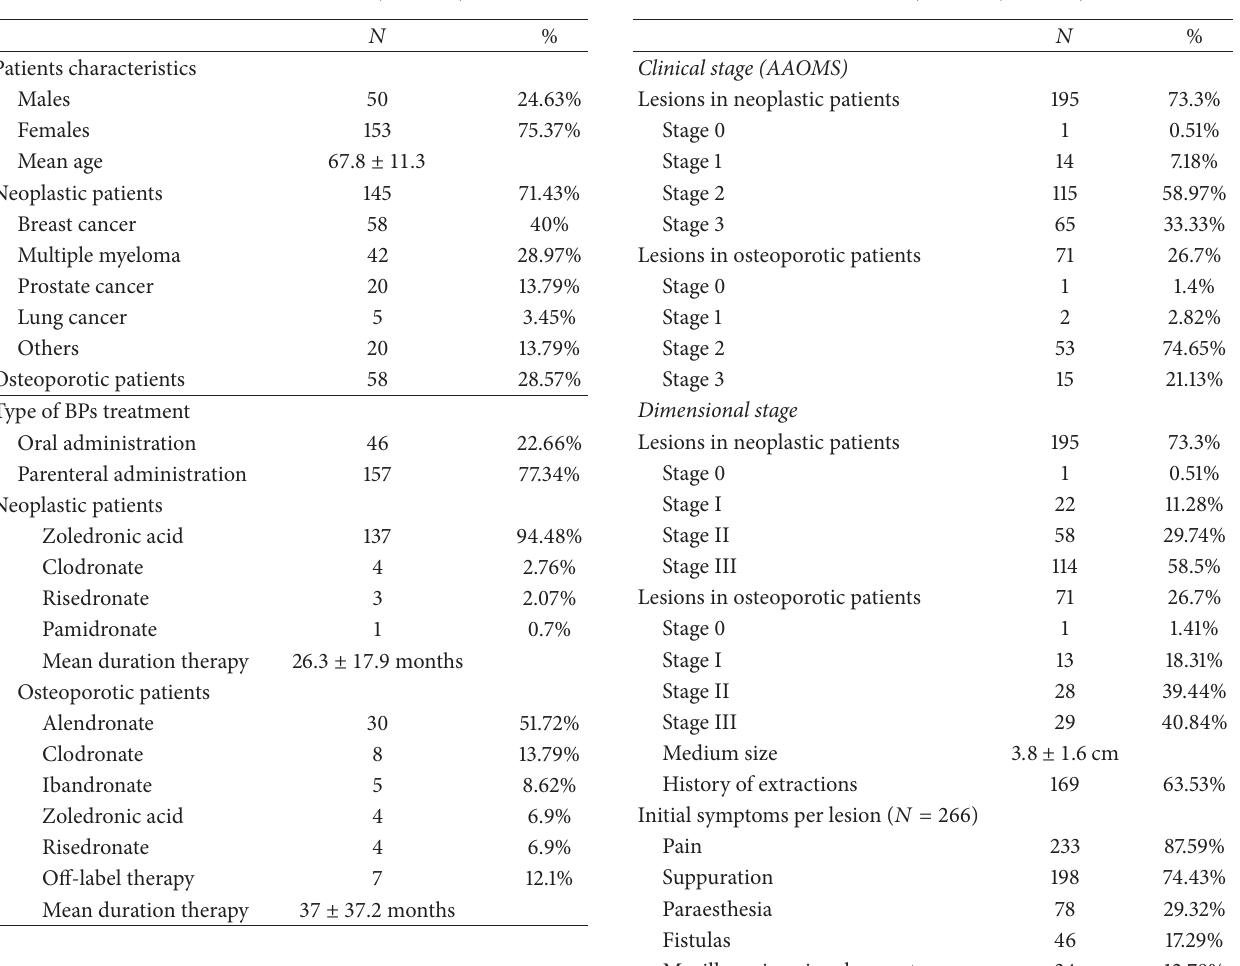
Table 3: Patients clinical data ( 𝑁 = 203 ). Table 4: BRONJ lesions ( 𝑁 = 277 ).